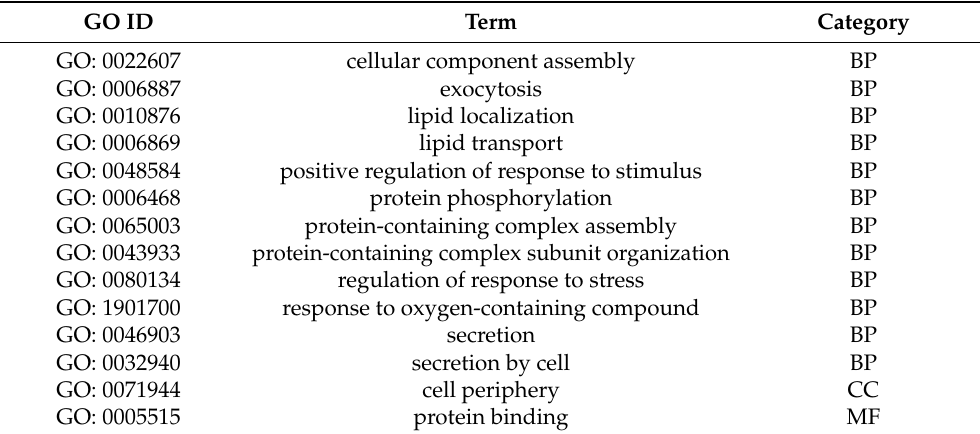
Table 1. Statistics of overlapping GO term in proteomic and transcriptome.